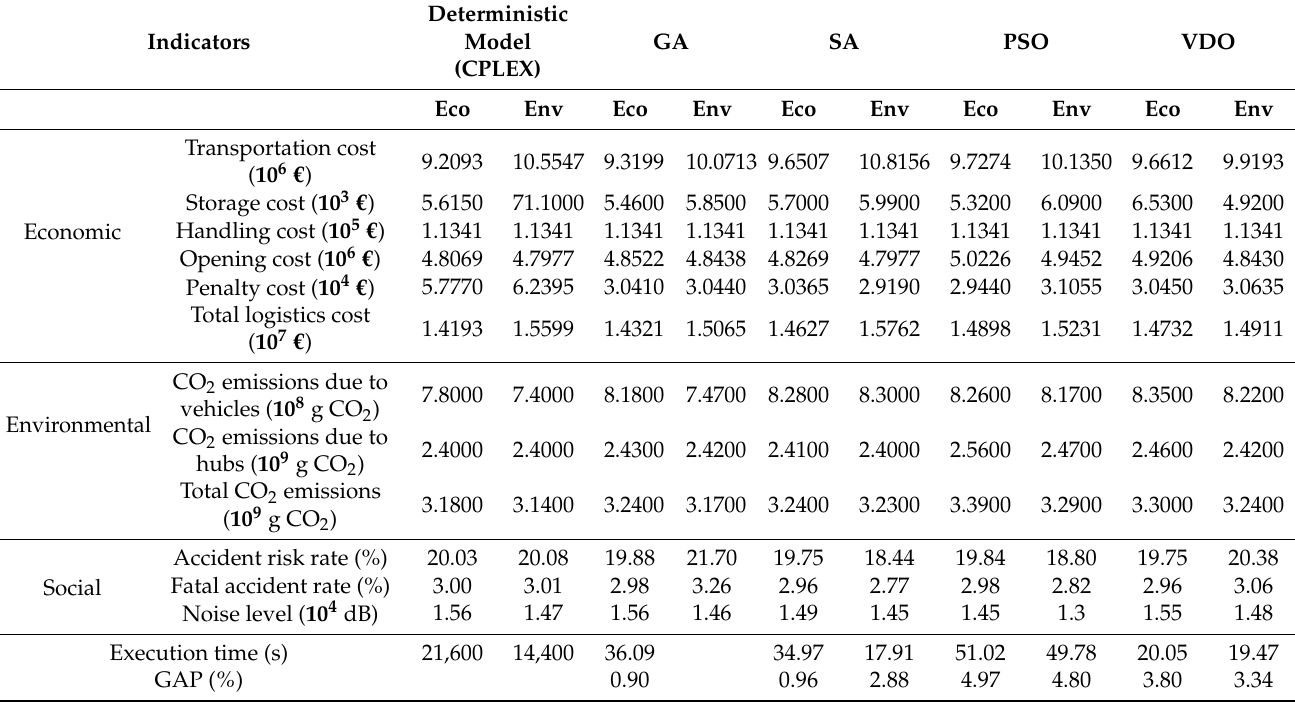
Table A7. Results of Sc2 for the different used methods.